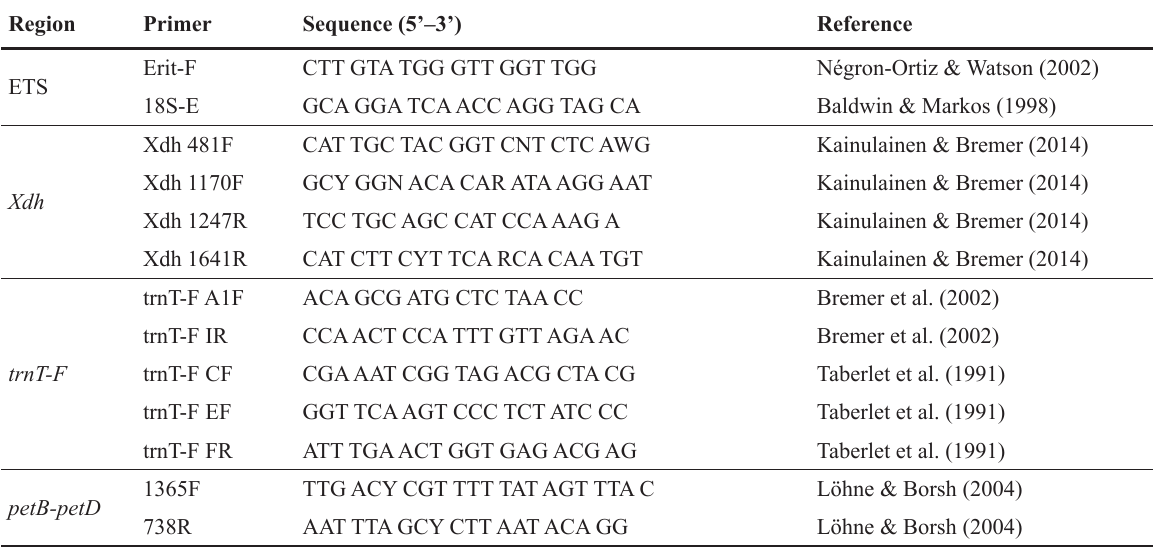
Table 1 – Primer information.